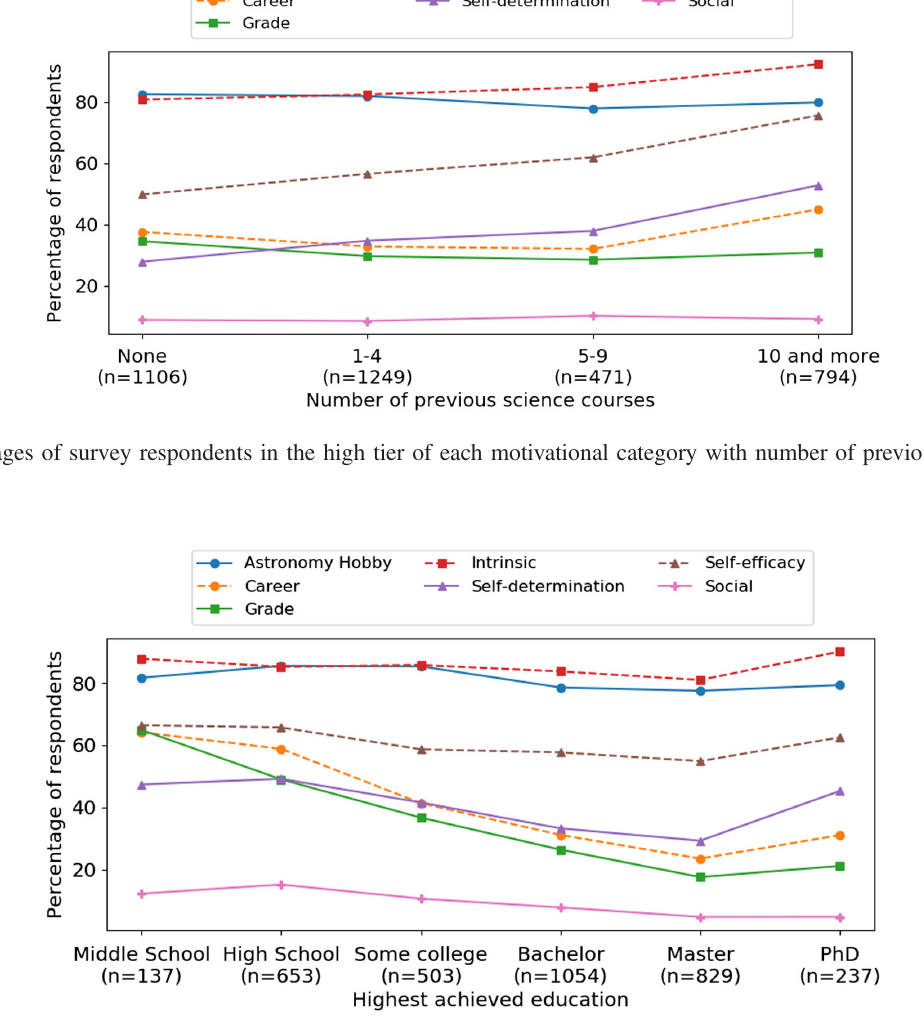
FIG. 6. Percentages of survey respondents in the high tier of each motivational category as a function of the highest achieved education.